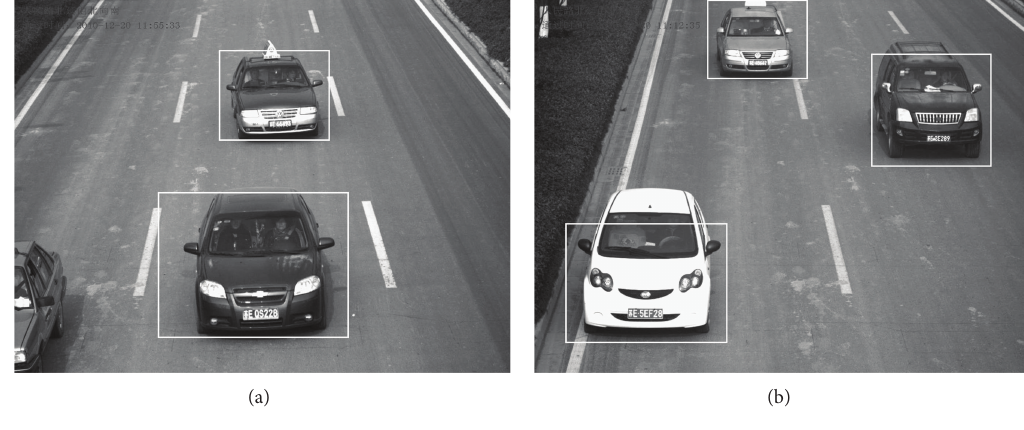
Figure 9: The multiple vehicles detection.